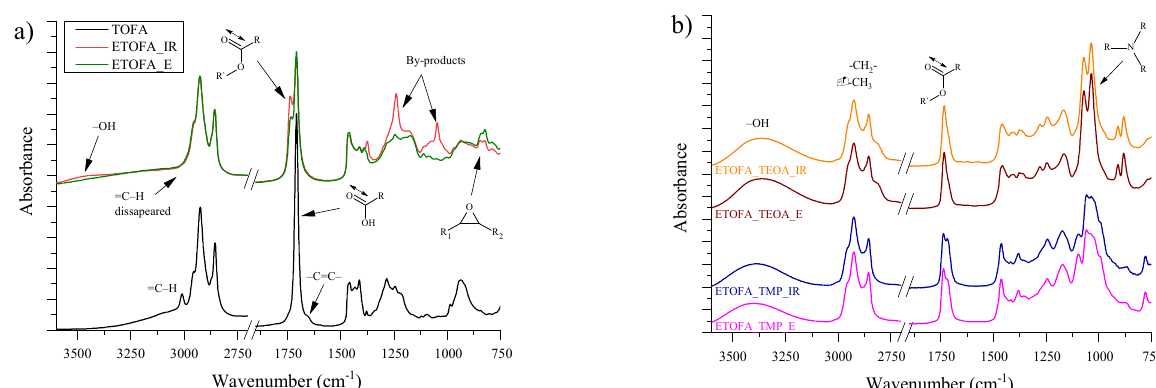
Figure 3. FTIR spectra: ( a ) spectra of TOFA, epoxidised tall oil fatty acids synthesised via TOFA epoxidation with ion exchange resin Amberlite IR-120 H (ETOFA_IR) and ETOFA obtained from TOFA epoxidation with lipase catalyst Novozym ® 435 (ETOFA_E) and ( b ) spectrum of the resulting TOFA-based bio-polyols.